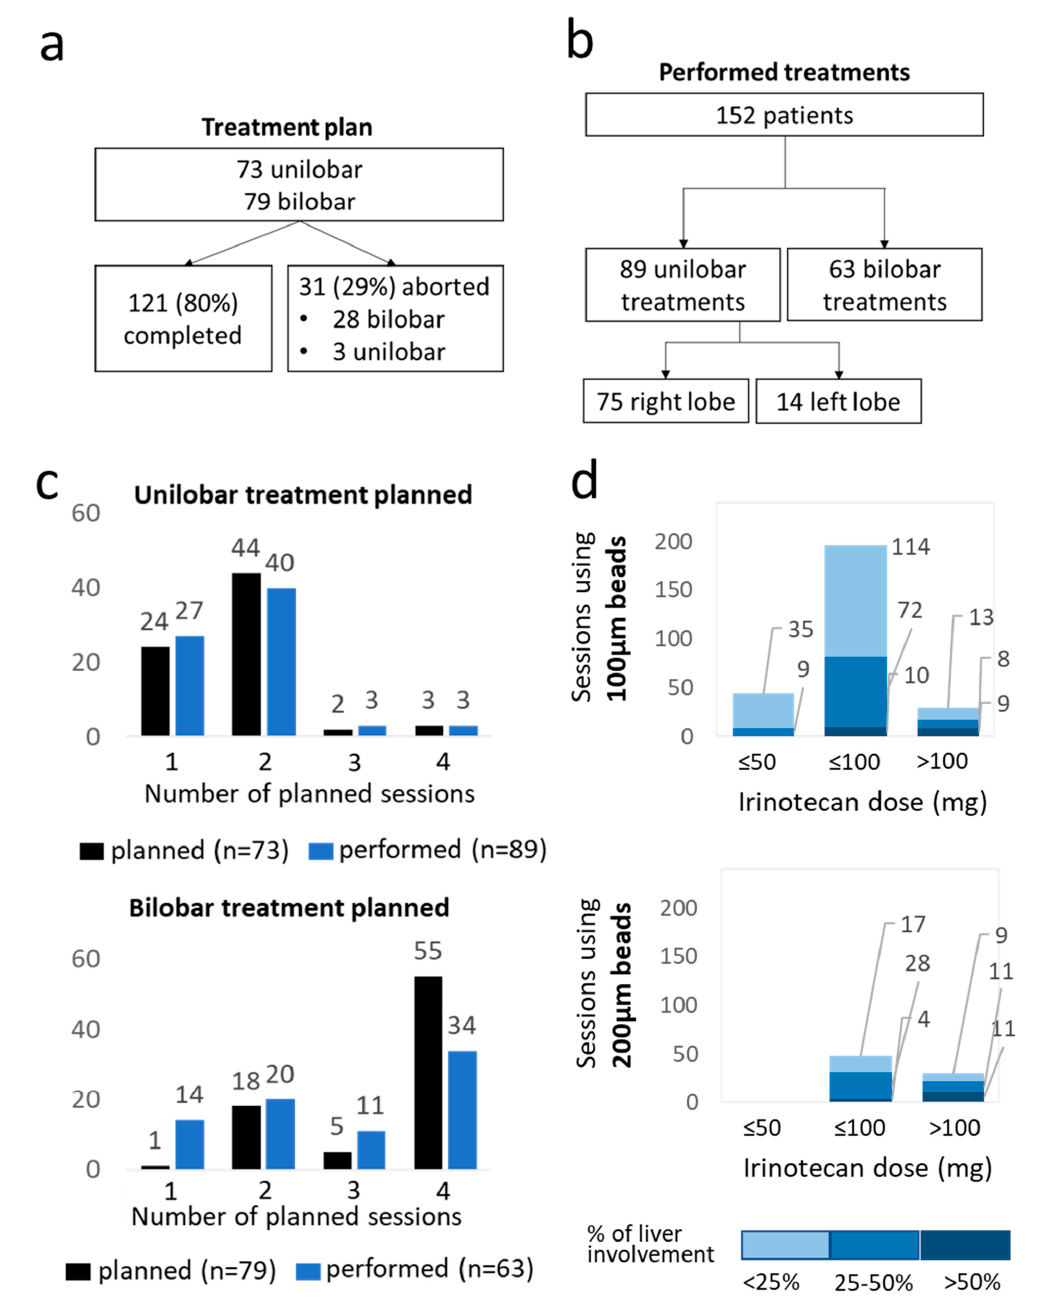
Figure 1. Technical considerations in terms of number of planned vs. performed treatment sessions and bead sizes and irinotecan doses used. Flowchart representing the number of planned uni- and bilobar tents, number of patients that did not complete the treatment plan ( a ). Flow chart representing the resulting number of performed uni- and bilobar treatments ( b ). The number of planned (dark blue) and actually performed (light blue) sessions per patients for uni- and bilobar treatment schedules ( c ). The number of sessions performed with 100 µ m and 200 µ m beads loaded with ≤ 50 mg, ≤ 100 mg and >100 mg irinotecan. The colours indicate the percentage of liver involvement from dark blue (>50%), medium blue (25–50%) and light blue (<25%) ( d